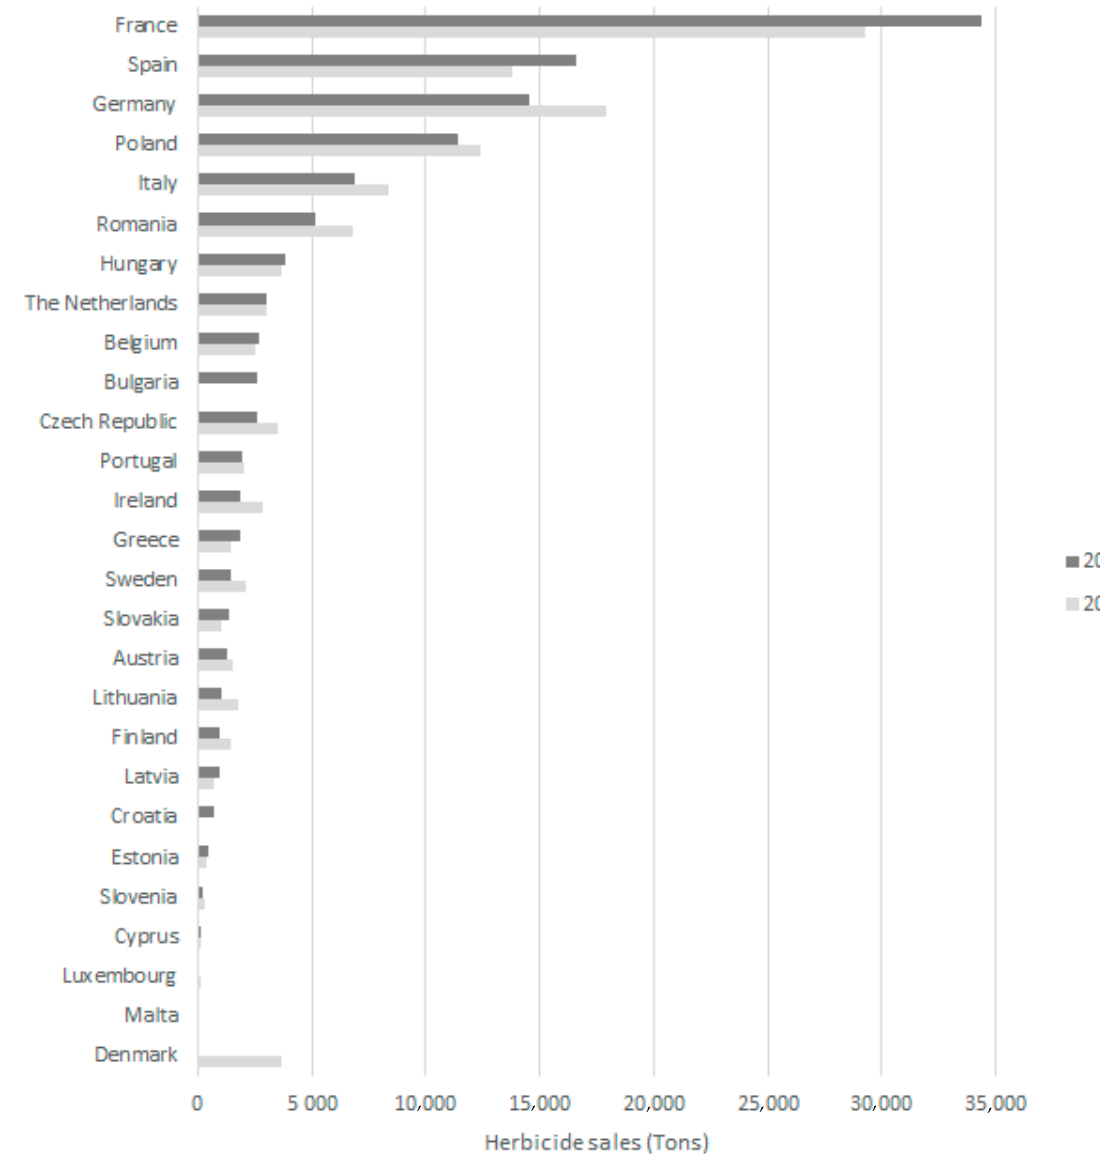
Figure 3. Herbicide sales in 2011 and 2018 in the EU.